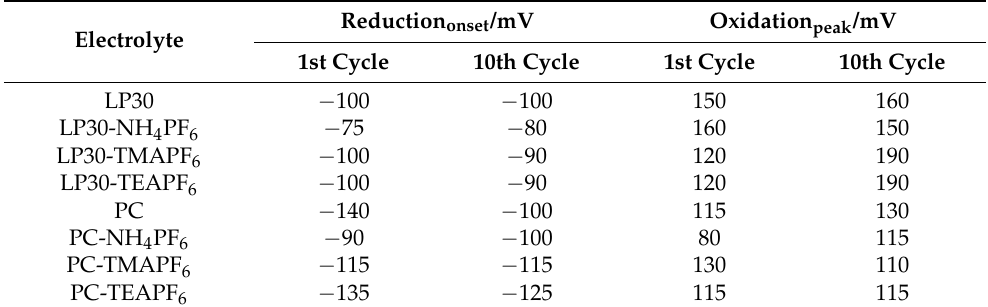
Table A1. Reduction and oxidation voltage data obtained from cyclic voltammetry of lithium plating/stripping.